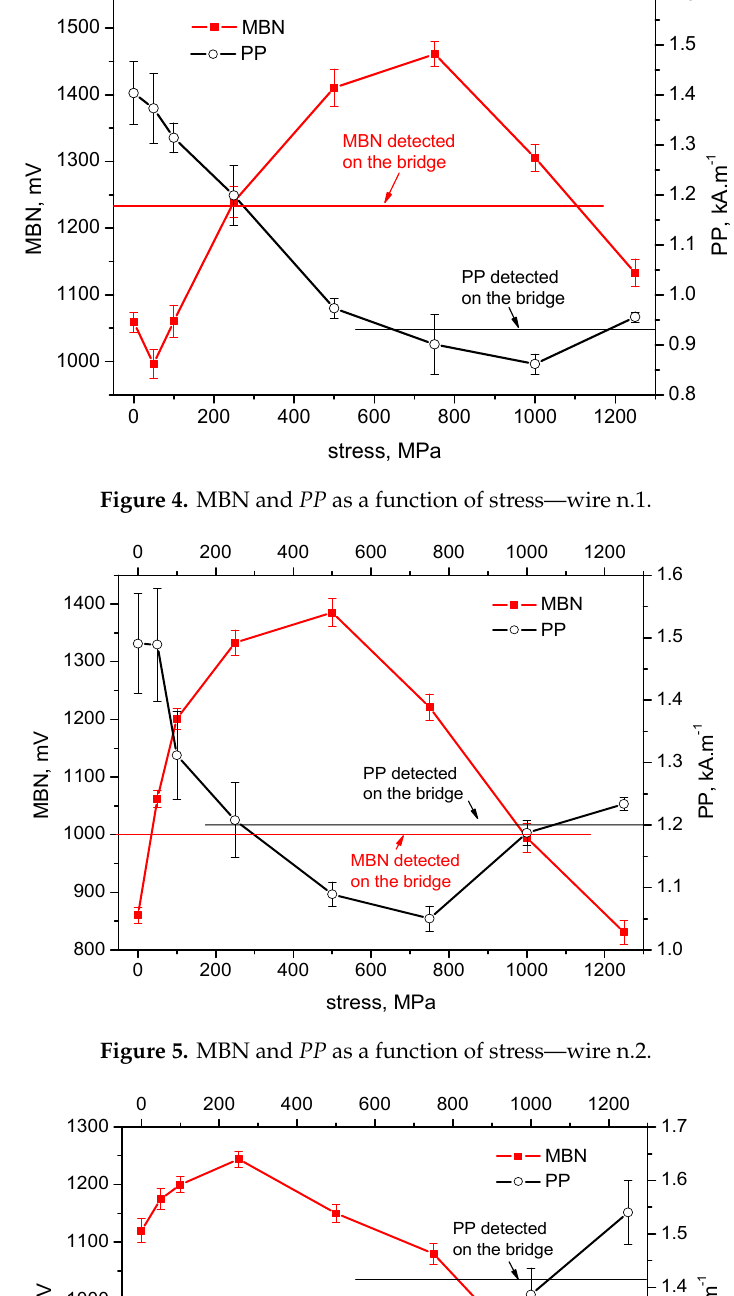
(b) Figure 3. Metallographic images of wire n.2’s cross-sectional view. ( a ) Region 1; ( b ) region 2. Figures 4–8 illustrate the evolution of MBN (its RMS, effective value) and PP for five different wires of the rope as a function of applied stress. It can be seen that the MBN values increase along with increasing tensile stresses. However, as soon as the tensile stress attains a certain maximum, the MBN drops for higher stresses. On the other hand, the evolution of PP exhibits the opposite trend. The PP values at lower stresses decrease followed by a visible increase at the end of the test when